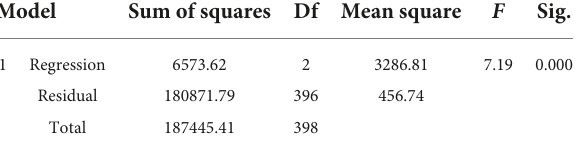
TABLE 5 ANOVA for teachers’ self-efficacy, academic buoyancy, and burnout. Model